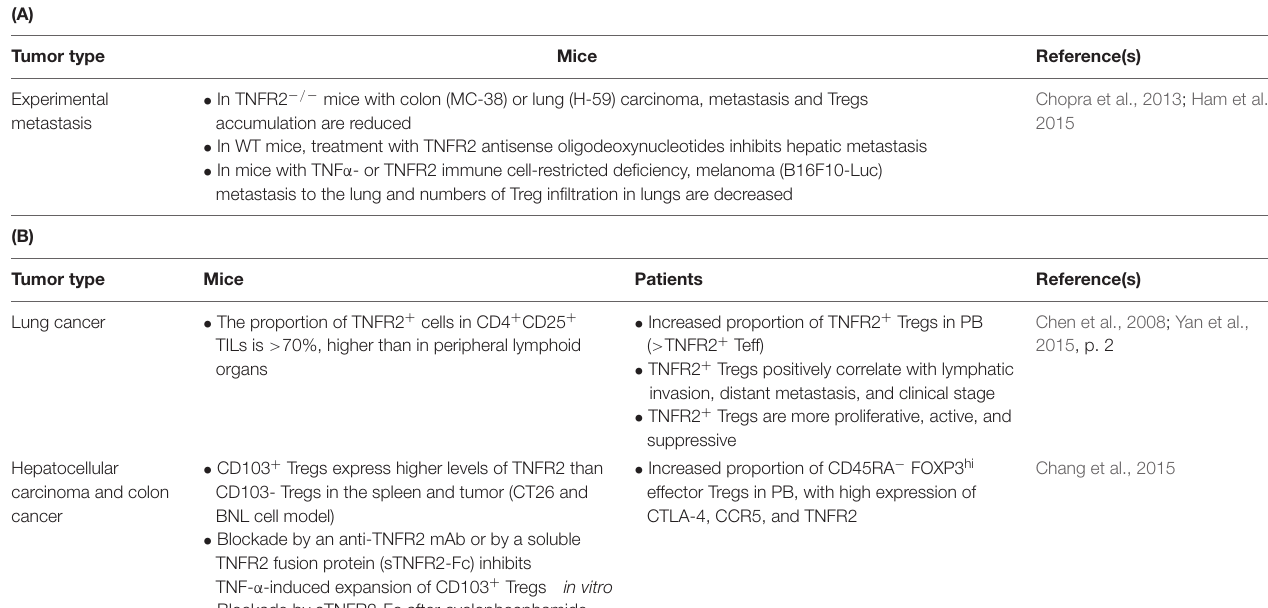
TABLE 2 | Role of TNFR2 + Tregs in cancer